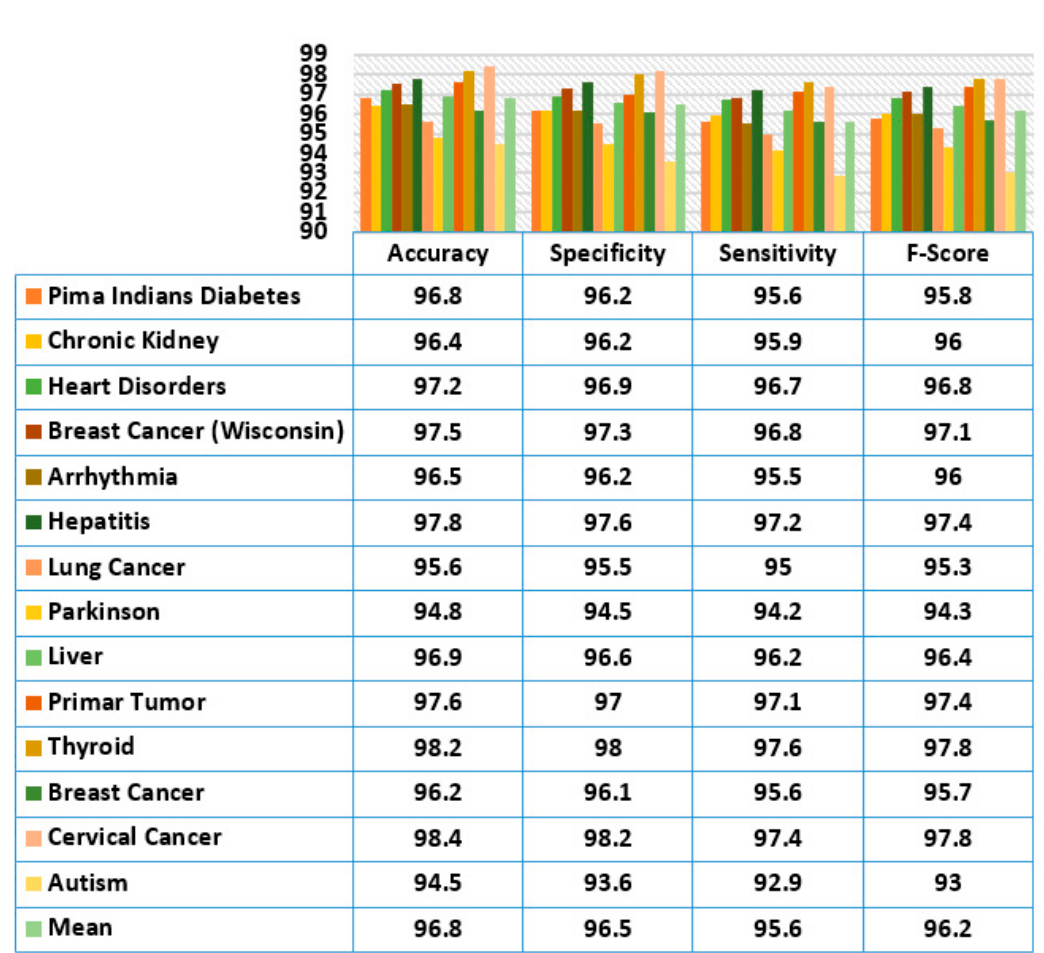
Figure 17. Evaluation of the Classification Performance of the Proposed Attribute Evaluator Method.